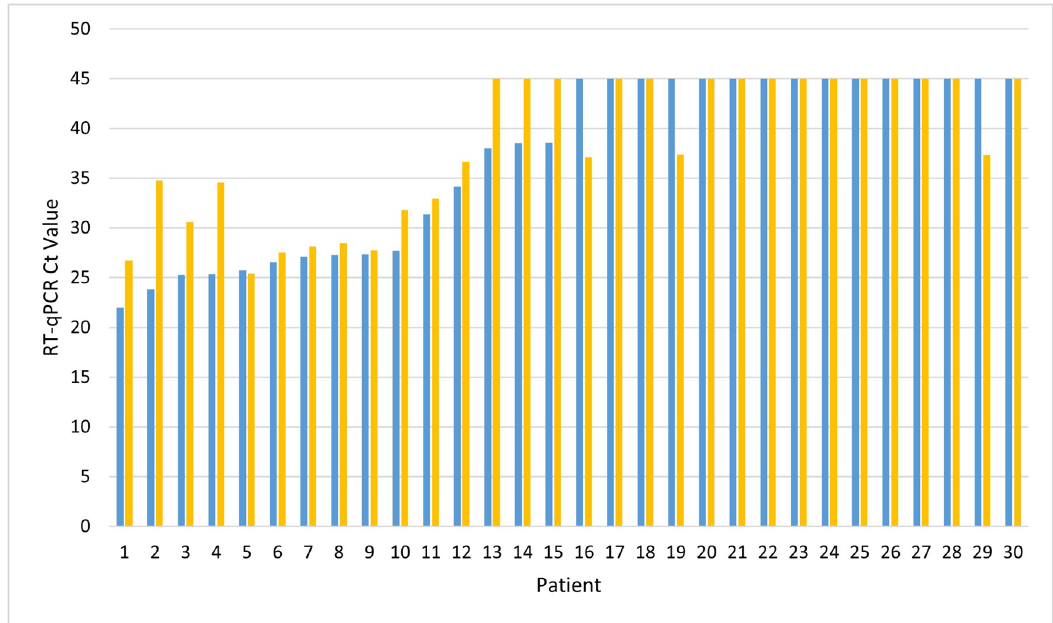
Fig 1. RT-qPCR results for SARS-CoV-2 detection utilizing the extraction-based or homogenization-based methods as demonstrated by paired Ct values. The blue bars depict Ct values following the extraction-based method and gold bars represent Ct values following the homogenization-based